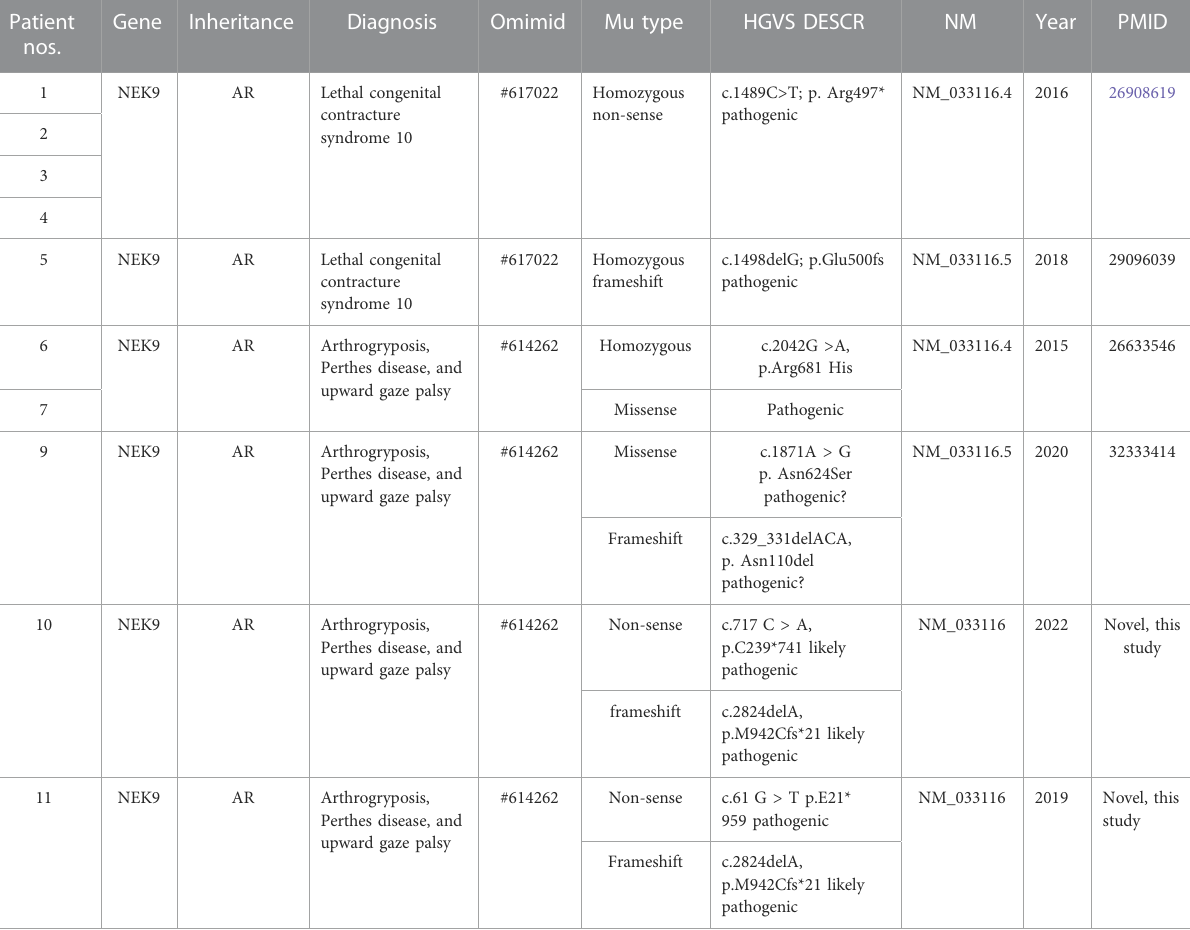
TABLE 2 Summary of genotype features of all reported patients involved in the NEK9 gene. Patient